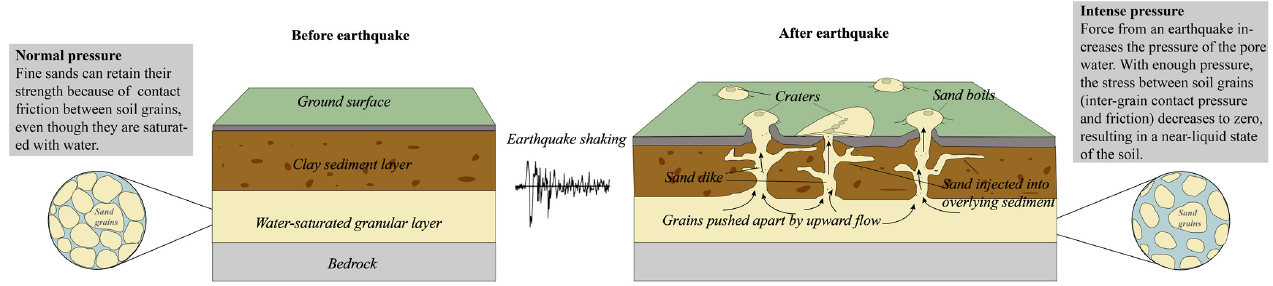
Figure 2. Schematic diagram illustrating the conceptual model of soil liquefaction during an earth- quake. This process mainly occurs in buried layers composed of water-saturated silt and fine sand [6–9]. Under excess pore water pressure caused by cyclic seismic loading, the groundwater-satu- rated sand will break through the cover layer or spray out the surface along the fissure, resulting in water spraying and sand bubbling and accumulating into mounds on the ground [6,7,10].